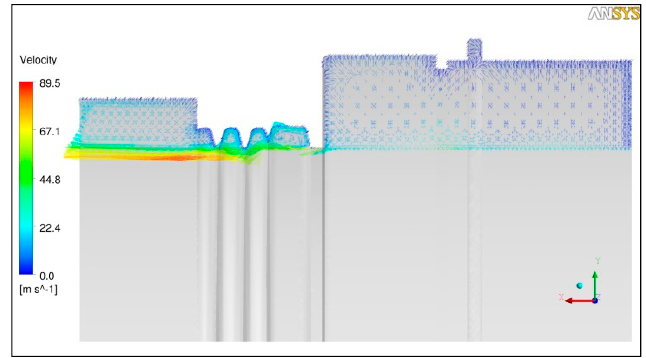
Figure 9. The axial velocity distribution in a longitudinal plane cut for the windback seal at 15,000 rpm. The helical cut forces the flow to move more circumferentially thus the carry over effect is lower compared to the labyrinth seal. For this reason, the windback seal produces higher pressure drop. In order to verify this assumption, the ratio of the tangential velocities in the cavities to the rotor velocity were plotted against the axial length of the seals. This is depicted in Figure 10. In the case of the windback seal the flow is accelerated in the direction opposite to the direction of rotation. This is not the case in the case of the labyrinth seal. The authors believe that the flow in the windback seal is ‘choked’, thus higher flow resistance and higher pressure drop result.